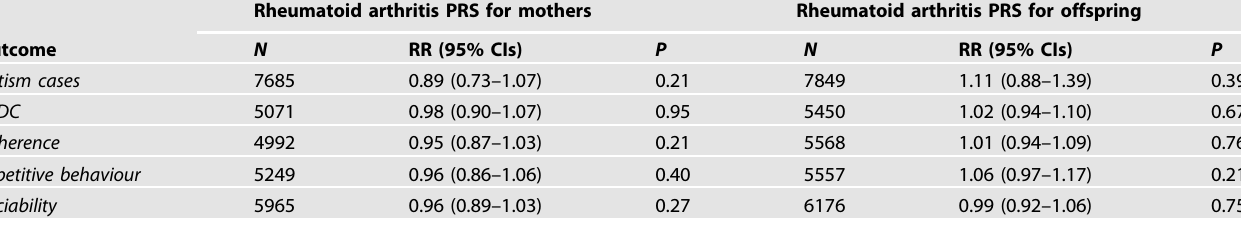
Table 1. Associations between PRSs and autism-related phenotypes at GWAS p -value threshold 0.05, adjusted for 10 genetic principal components. Rheumatoid arthritis PRS for